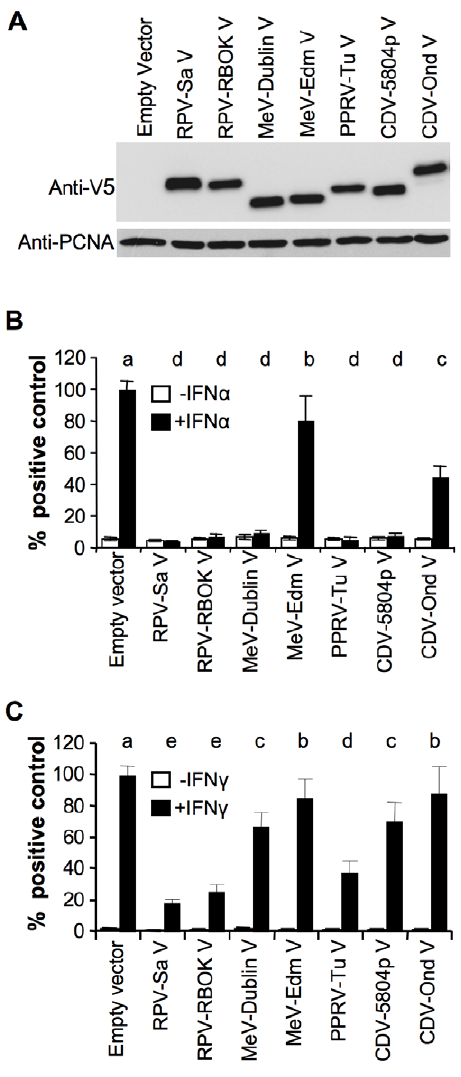
Figure 2. Abilities of morbillivirus V proteins to block type I and type II IFN induced gene transcription. (a) Vero human-SLAM cells were transfected with 0.5 m g of empty vector or plasmid driving the expression of the indicated protein. Twenty-four hours post transfection, cells were lysed in SDS-PAGE sample buffer and the expressed proteins were detected by Western blot using mouse anti-V5 antibody. PCNA levels served as loading control. (b), (c) Vero human- SLAM cells were transfected with 0.5 m g each of (b) pGL3-MX1P-luc or (c) pGAS-luc, together with pJATLacZ and either empty vector or plasmid driving the expression of the indicated protein. Twenty-four hours post-transfection, cells treated with either (b) 1000 IU/ml of IFN a or (c) 1000 IU/ml of IFN c or left untreated, lysed and assayed for luciferase and b -galactosidase activities as described in Methods. Letters above the bars for the IFN-treated samples indicate the results of statistical analysis: results which were not statistically different from one other have the same